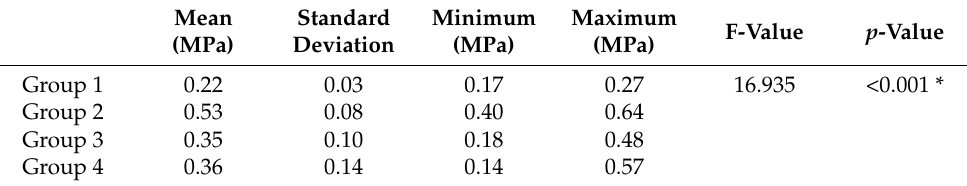
Table 6. Comparison of the mean values of tensile strengths in Groups 1–4 using One-way ANOVA.